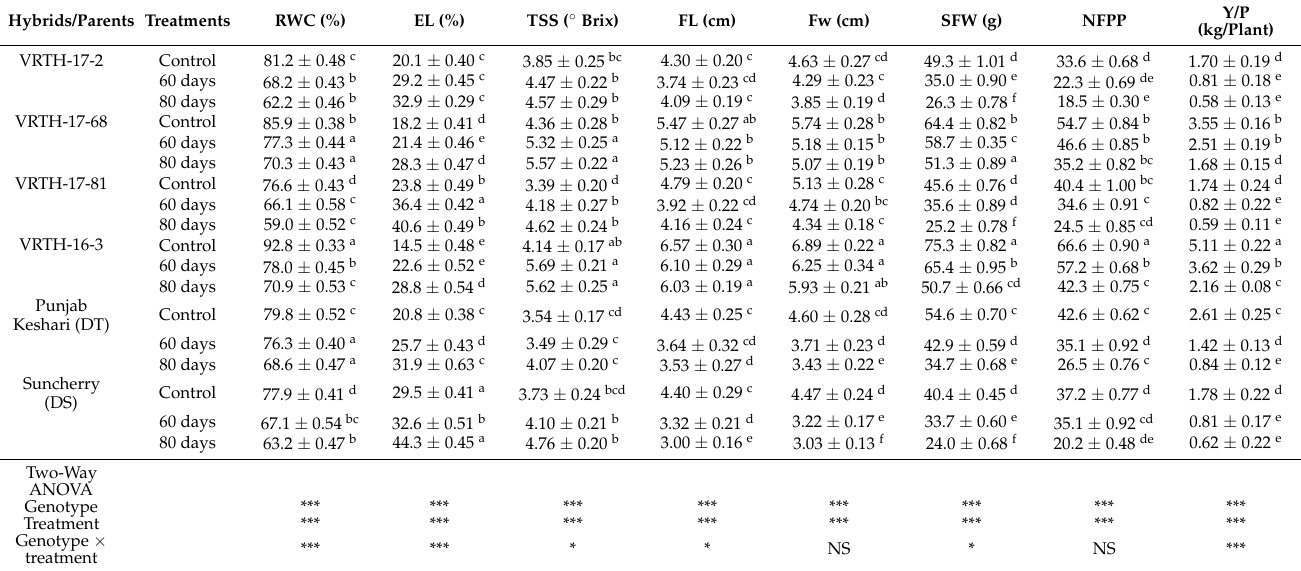
Table 3. Changes in physiological and yield-related attributes in tomato hybrids/parents under drought